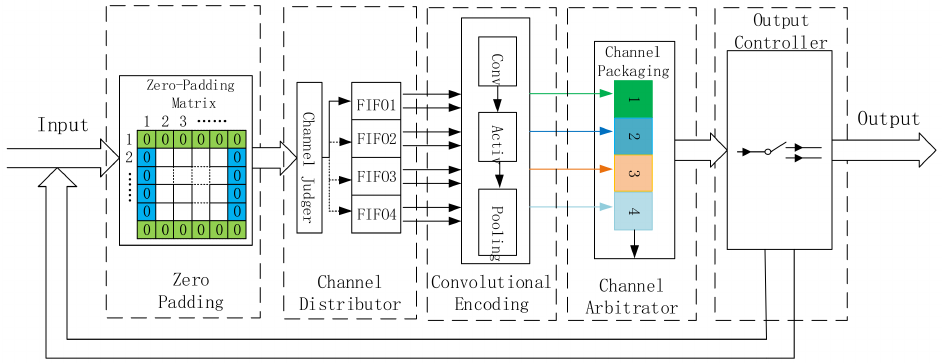
Figure 2. The encoder of the proposed CAE hardware framework. The different colors marked in the zero padding module indicate different filling methods: the first and the last row are filled all zeroes, while the intermediate matrix is padded zeroes only at the beginning and the end of each row. The different colors marked in the channel arbitrator module represent the corresponding four channels for